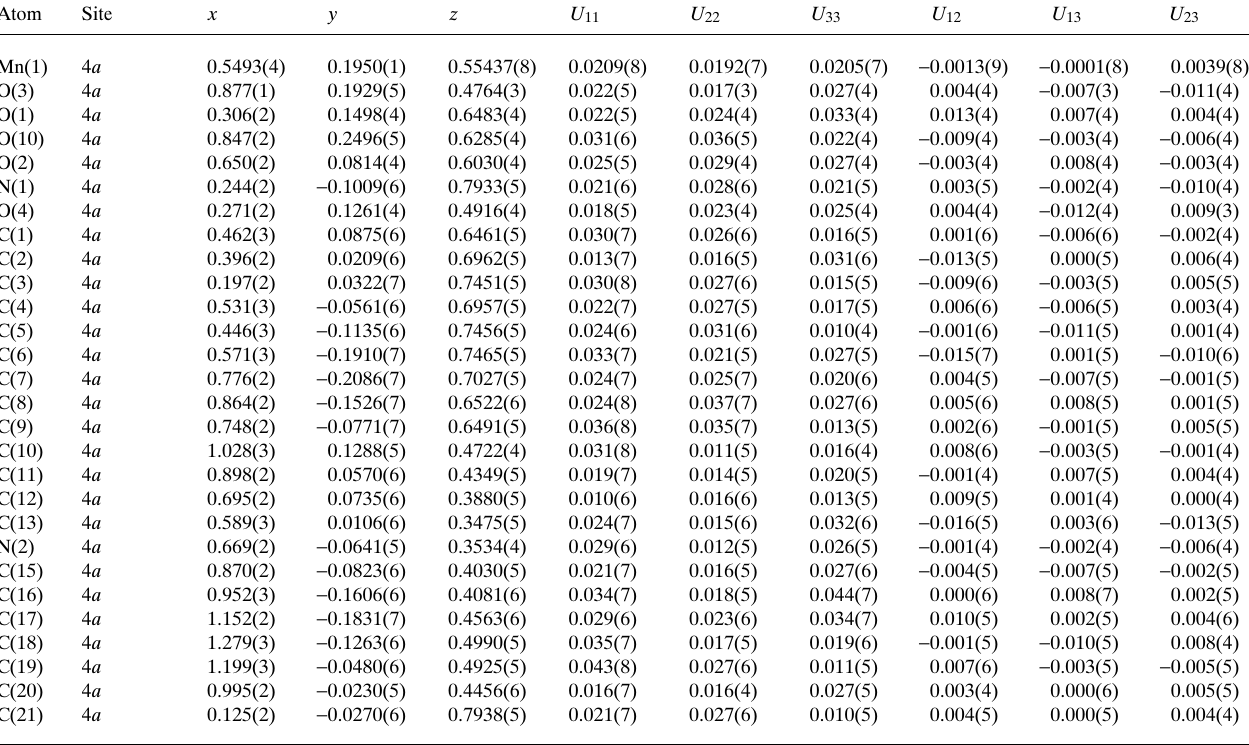
Table 3. Atomic coordinates and displacement parameters (in Å 2 ) .